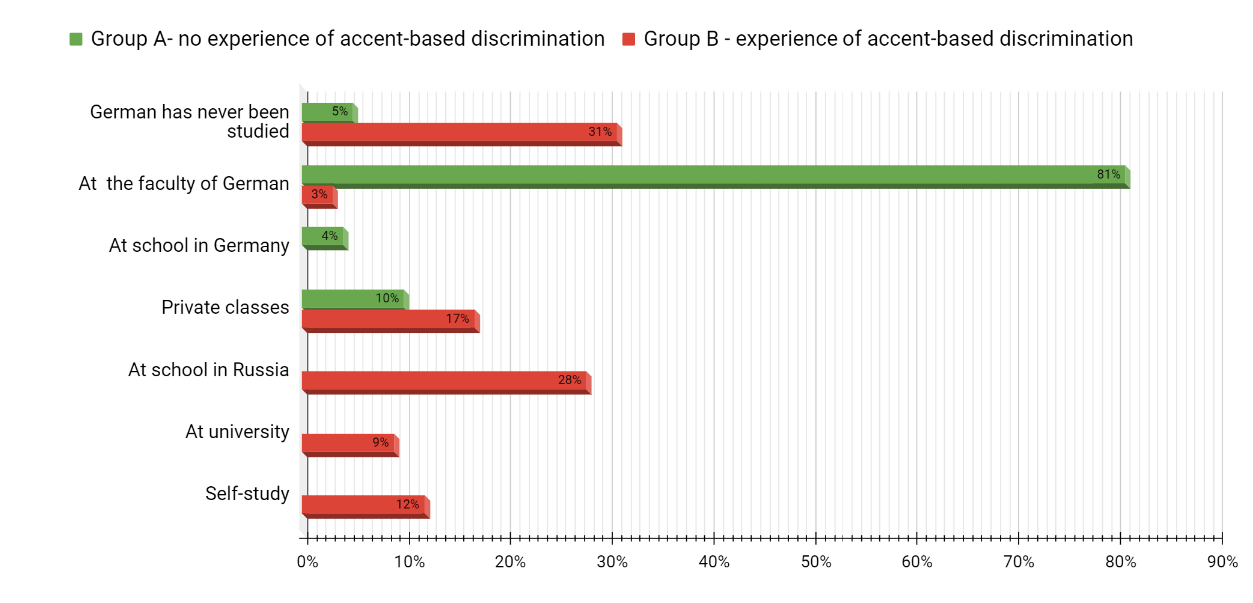
Fig.1 — Comparative characteristic of ways to learn German